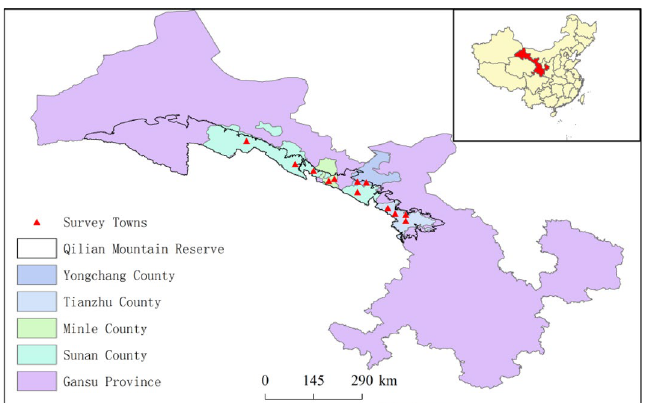
Figure 1. Map of Gansu Province, China showing the survey area. Map of these distinct was drawn by ArcGIS 10.2(https:// www. esri.